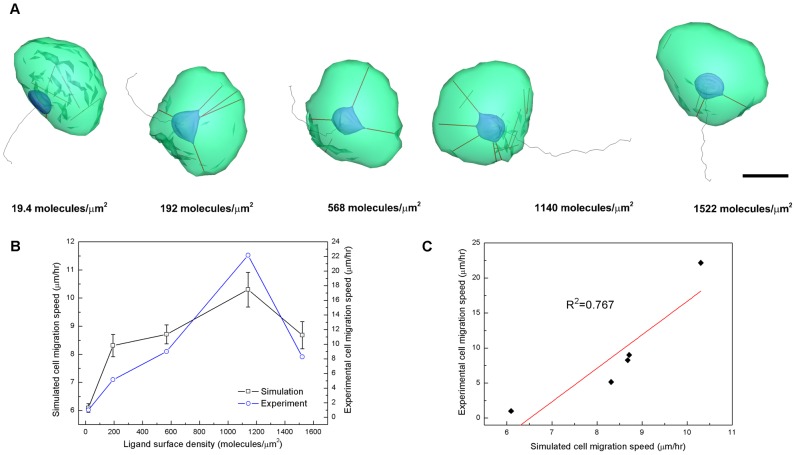
Cell migration along the planar surface of fibronectin.A) Simulated trajectories of cell migrations on fibronectin coated substrates under five different ligand surface densities of 19.4, 192, 568, 1140 and 1522 molecules/µm2. The black lines indicate trajectories of nuclei for the first three hours, B) comparison of average cell migration speeds: the simulation model vs. experiment data by Palecek et al.
[17]. Average speed and standard error of mean (N = 5) are shown for the five different ligand surface densities, and C). linear regression (R2 = 0.767) of simulated migration speed vs. experimental migration speed.